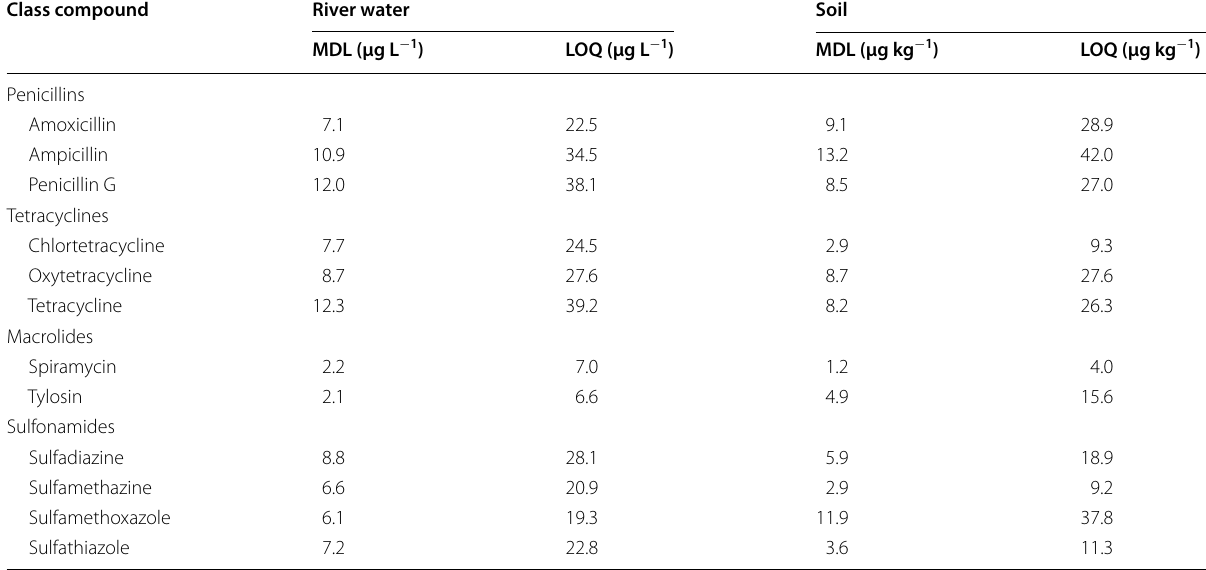
Table 2 MDL and LOQ for the target analytes in river water and soil sample Class